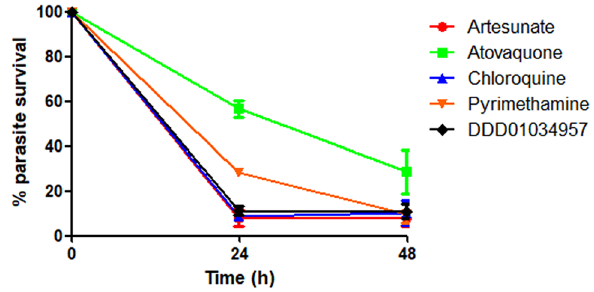
Figure 2. DDD1034957 rapidly kills P. falciparum 3D7 strain asexual parasites. Parasites were treated either with ten-times (10 ×) the asexual IC 50 of DDD1034957 or 10 × IC 50 of a range of control antimalarials and then sampled at 24 h and 48 h after treatment. Samples were washed to remove drugs and cultured with fresh erythrocytes that had been fluorescently labelled with carboxyfluorescein diacetate succinimidyl ester (CFDA-SE). After a further 48 h, parasites were labelled with Hoechst 33342 and these doubly-labelled cells (indicating viable parasites that had invaded fresh erythrocytes after drug treatment) were quantified by flow cytometry. DDD1034957 achieved rapid parasite kill after only 24 h treatment showing fast-acting kinetics similar to artesunate and chloroquine. Data shown is the mean of three independent experiments and error bars denote the